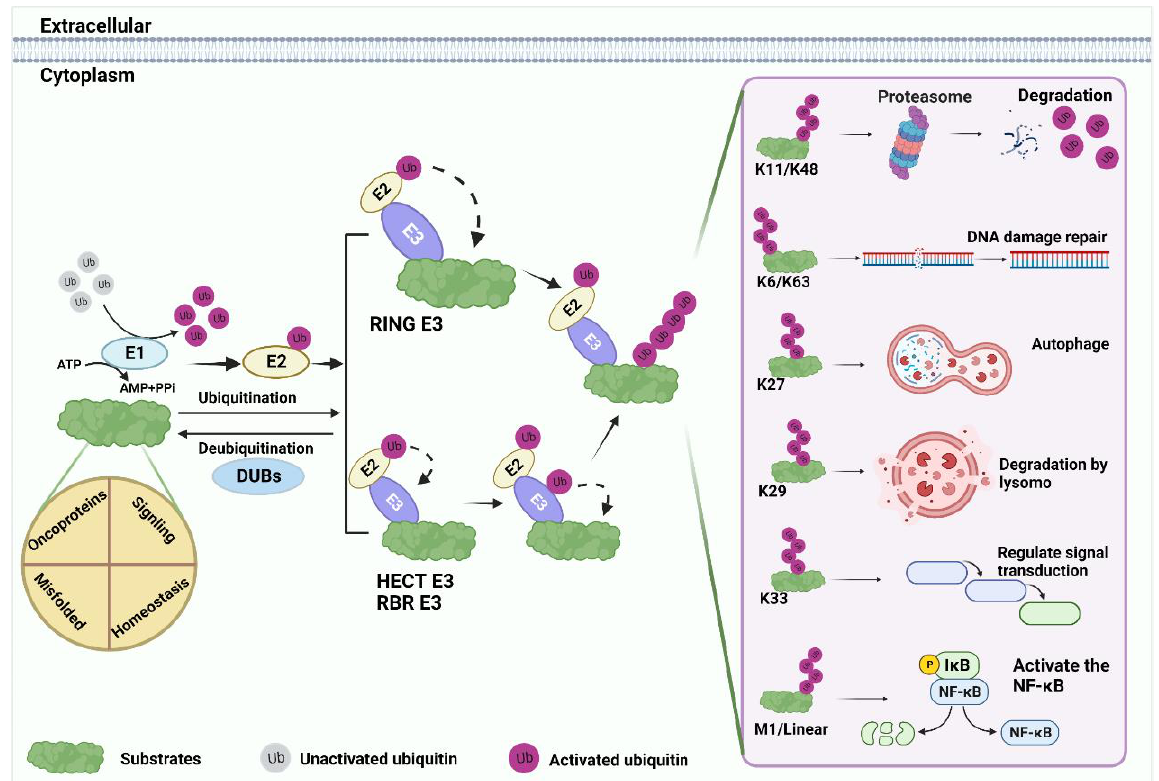
Figure 1. Ubiquitination processes. Substrate ubiquitination is an ordered process. First, under the premise of ATP energy supply, the Ub molecule is activated by E1, and the 76th Gly at the Ub terminus forms a mercaptan lipid bond with E1 cysteine. Subsequently, Ub is shifted to E2 by the E1 intermediate. Finally, E3 ligase transfers Ub directly or indirectly to substrates by recruiting E2. The substrate binds to lysine residues of the Ub polypeptide to form seven poly-Ub chains with different fates: K11 and K48 are commonly associated with substrate degradation. K6, K63, K27, K29, and K33 mediate the regulation of various substrate functions. For example, DNA damage repair, protein autophagy, lysosomal degradation, signal transduction, and so on. M1 and linear Ub chain can positively regulate the nuclear factor kappa-B (NF- κB) si gnaling.